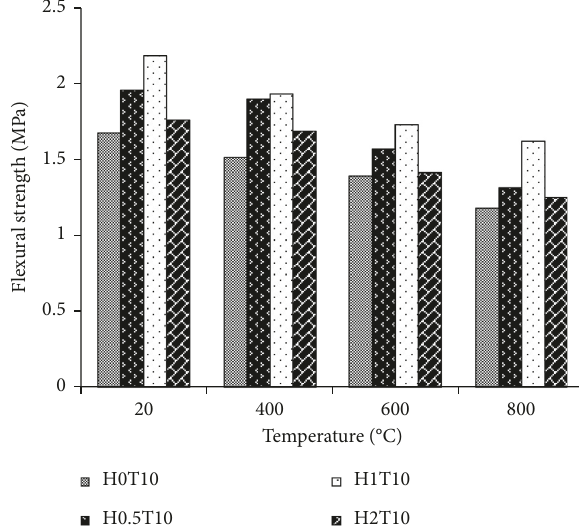
Figure 3: Compressive strength results for carbon fiber-reinforced lightweight concrete containing 20% silica fume.